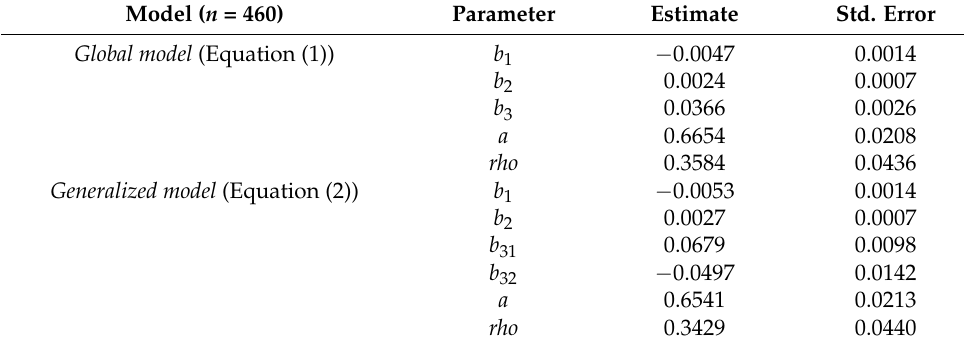
Table 2. Parameter estimates for the horizontal branch biomass density distribution, where rho represents the estimated autocorrelation